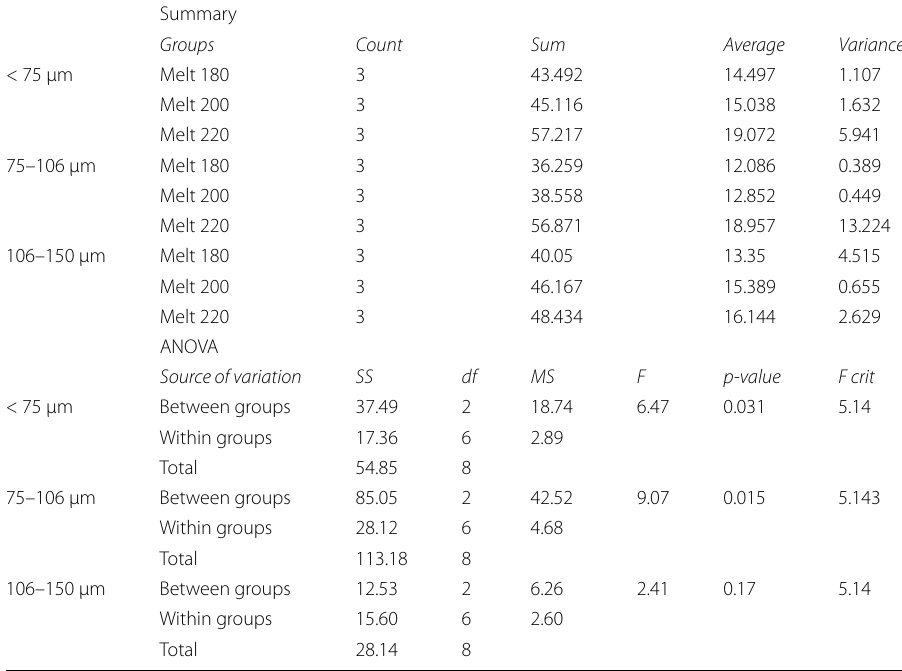
Table 5 One-way ANOVA results of impact strength: effect of injection temperature